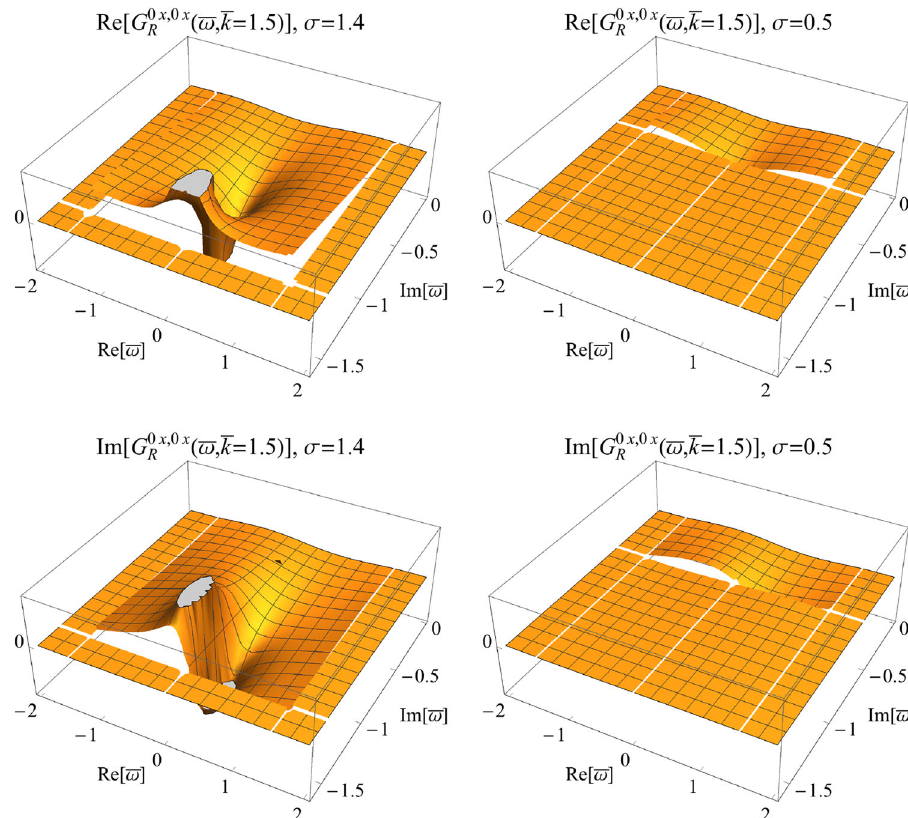
Fig. 7 The real and imaginary part of the retarded correlation ( ¯ ω, ¯ k = 1 . 5 ) , function G 0 x , 0 x R evaluated for choices of the logarithmic branch cuts depicted in Fig. 6. Left hand side: If the two branch cuts are joined at imaginary depth σ = 1 . 4, then the shear pole is clearly visible above the cut. Right hand